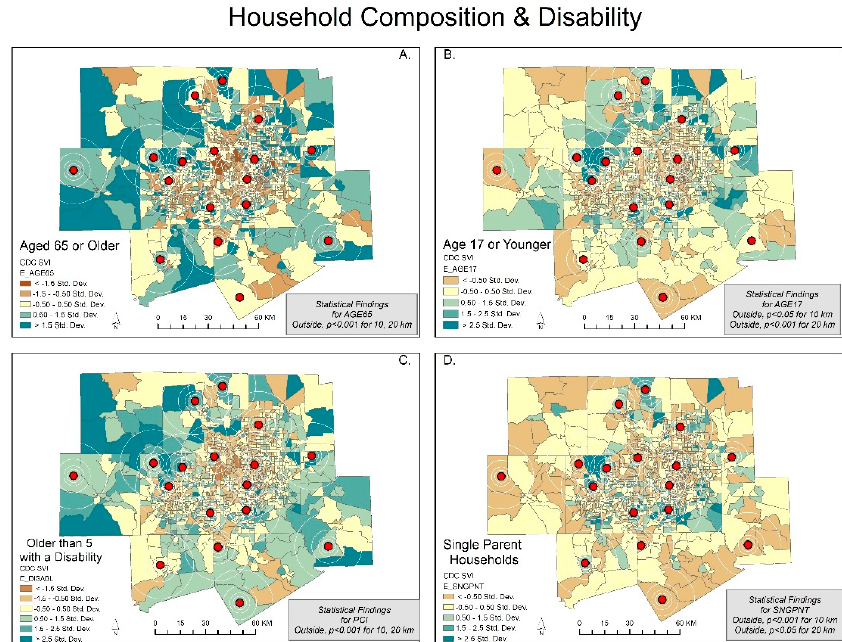
Figure 3. Dallas—Fort Worth: SD classification scheme of social variables for household composition and disability. The CDC/ATSDR SVI variables include Figures; ( AH ) aged 65 or older; ( BI ) age 17 or younger; ( CJ ) older than 5 with a disability; ( DK ) single parent households.